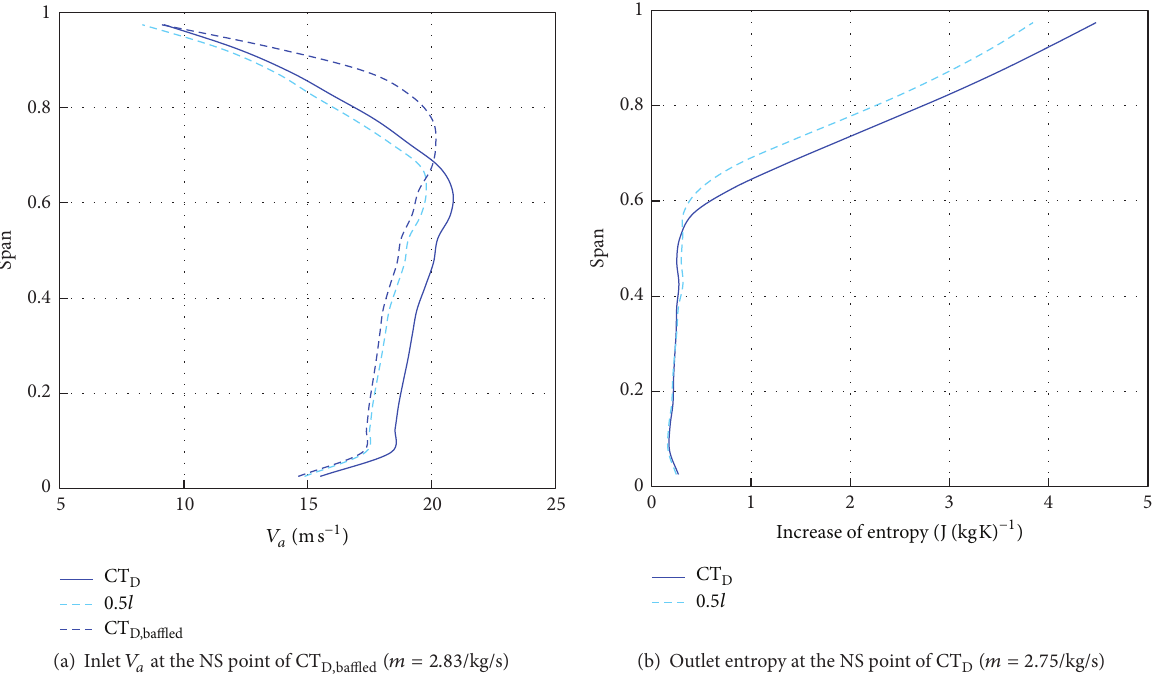
Figure 19: Distribution of the pitch-average parameters for CT D , 0.5𝑙 baffled case, and CT D , baffled .